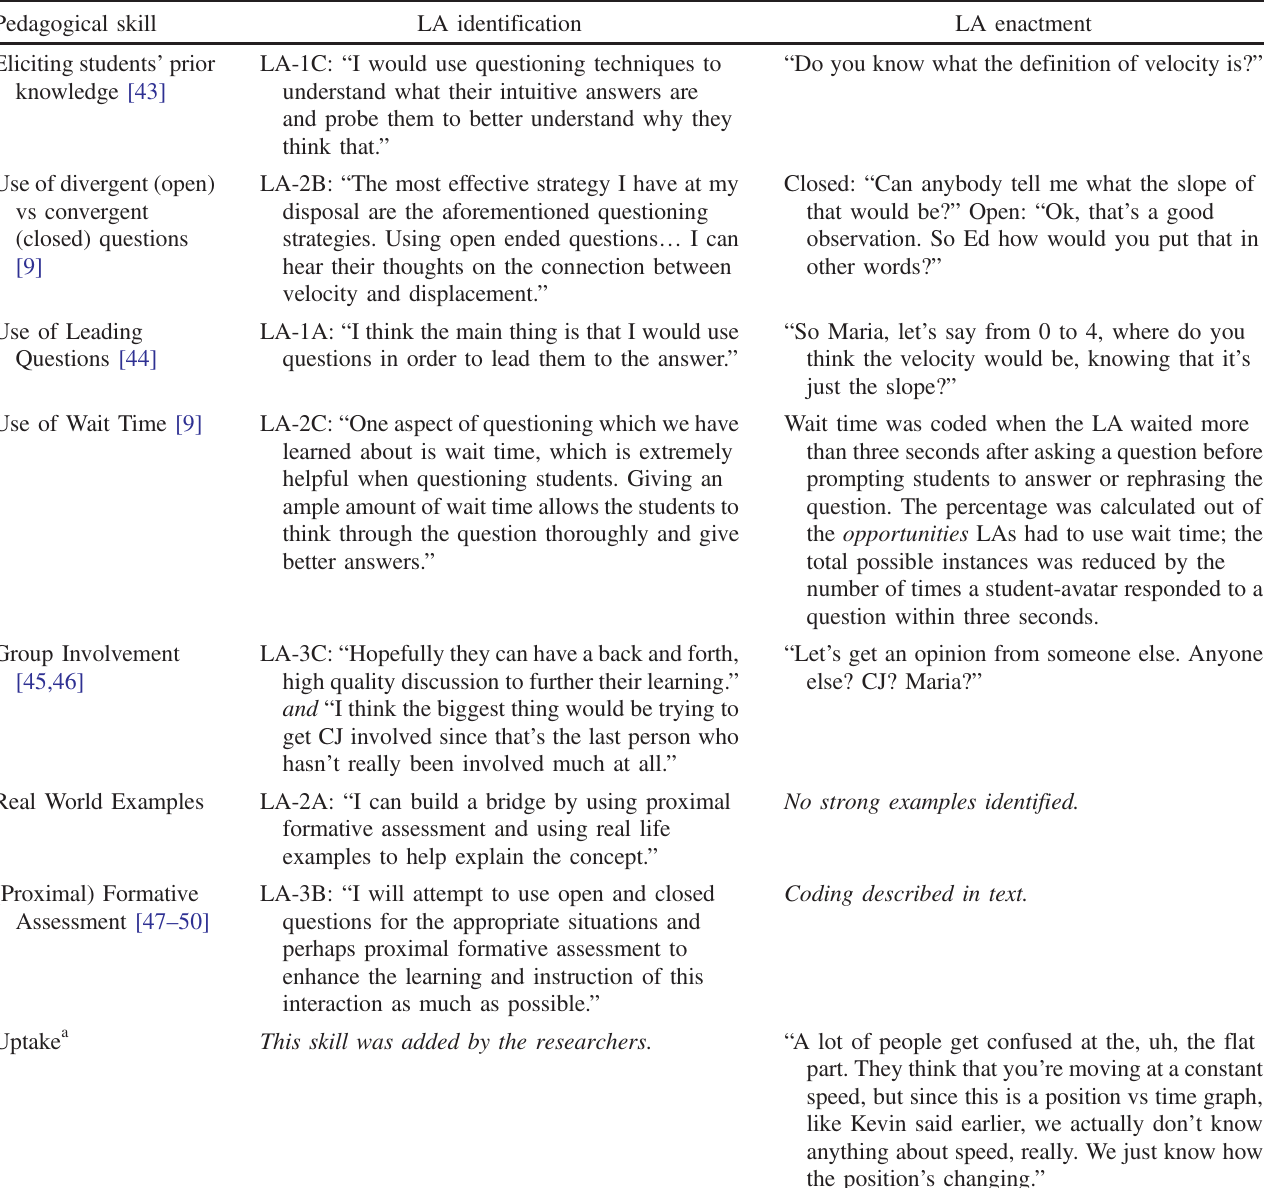
TABLE II. Framework for pedagogical skills. Strategies were identified from LAs ’ writing. References indicate the literature LAs were exposed to through their pedagogy seminar. Examples are given of how LAs identified the intention to use each skill and how LAs enacted each skill in the